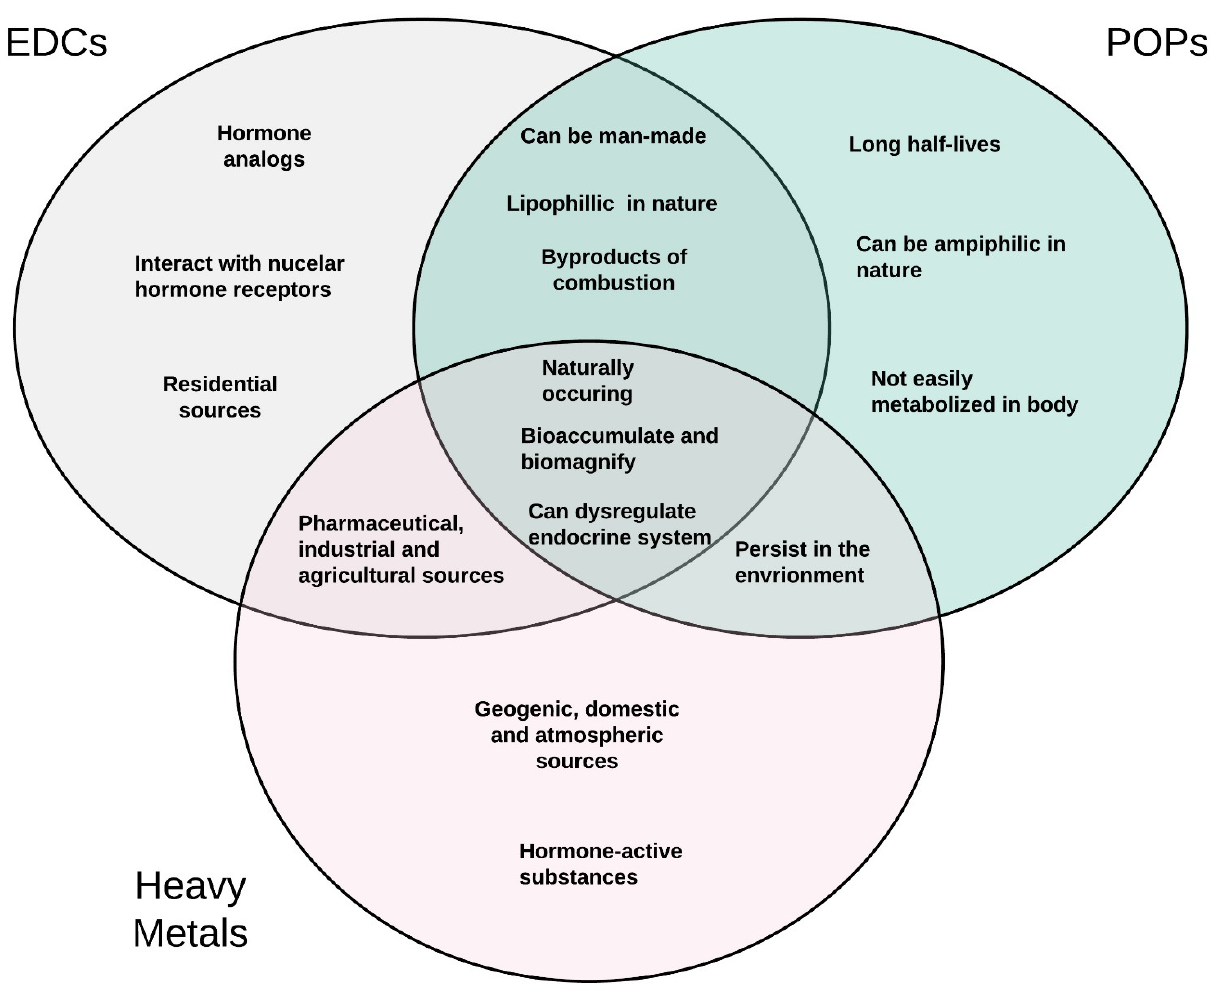
Figure 4. A three-way Venn diagram displaying commonalities and differences in the characteristics of POPs, EDCs, and heavy